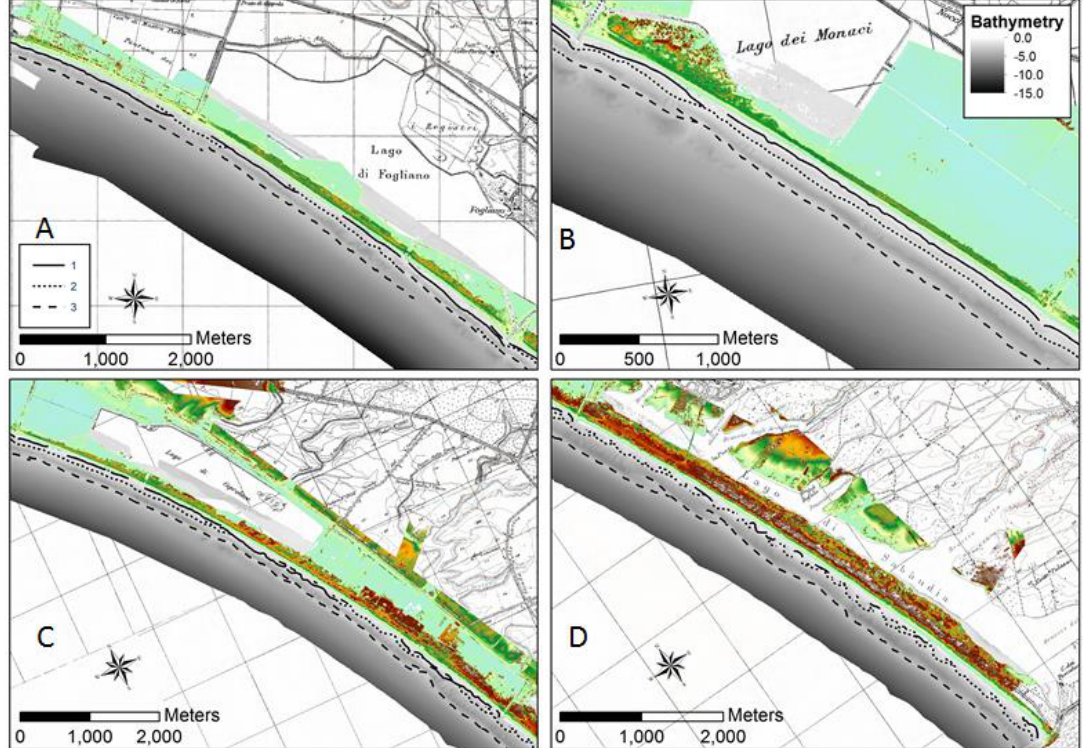
Figure 10. Examples of different morpho-bathymetric asset of sand bar crest (black lines) within the study area. From North to south the following bedforms can be observed: ( A ) IB and OB with some evidence of LTT in the southern part; ( B ) well developed and linear LTT, IB and OB system ( C ) Presence of the OB and passage from LTT and IB to TBR in the southern part; ( D ) fully developed TBR in the inner part of the submerged beach and in some part of the OB.